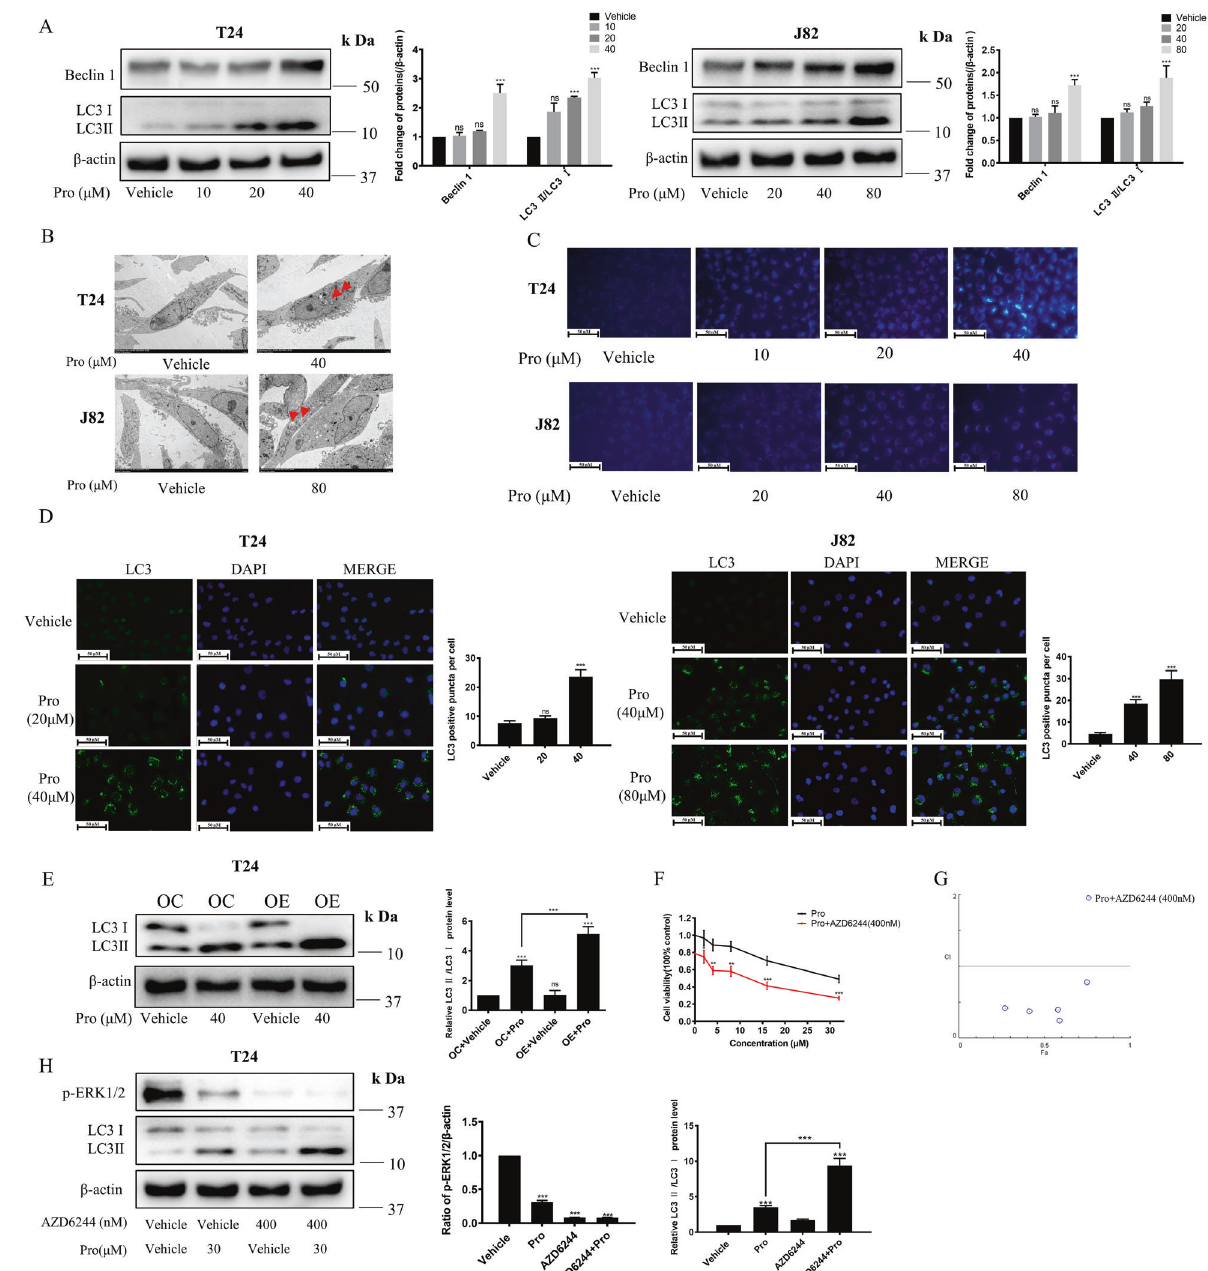
Fig. 6 Proguanil induces autophagy in BC cells. A T24, J82 were plated in 6-well plates (3.0 × 10 5 /well). When the cell density reaches 70 – 80%, cells were treated with proguanil for 12 h, and the protein expressions of LC3 and Beclin-1 were detected by WB. B When the density of T24 and J82 reaches 70 – 80% in 75 cm 2 vented culture fl asks, cells were treated with proguanil for 12 h. Subsequently, cells are then fi xed with electron microscope fi xative and observed under a transmission electron microscope (Red arrows indicate autophagosomes). C T24, J82 were plated on glass disks in 12-well plates (8.0 × 10 4 /well) and treated with proguanil for 12 h. Subsequently, cells washed with wash buffer and stained with MDC as described in “ Materials and methods ” , and then observed under an inverted fl uorescence microscope. D T24, J82 were plated on glass disks in 12-well plates (2.0 × 10 4 /well), After 24 h, cells were treated with proguanil for 12 h. The effect of proguanil on LC3 was detected by immuno fl uorescence. E T24, OE-T24 were plated in 6-well plates (3.0 × 10 5 /well). When the cell density reaches 70 – 80%, cells were treated with proguanil for 12 h, the effect of proguanil on the expression of LC3 was detected by WB. F T24 were plated in 96-well plates (6.0 × 10 3 /well) and pretreated with 400 nm AZD6244 for 12 h before exposure to increasing concentrations of proguanil for an additional 72 h, the combined effect of proguanil and AZD6244 was detected by MTT assay. G Combination index (CI) among the combinations of two drugs was calculated using CompuSyn software. if CI > 1, it denotes antagonism; if CI < 1, it denotes synergism. CI values in all of combinations were less than 1, indicating synergism. H T24 were plated in 6-well plates (3.0 × 10 5 /well). When the cell density reaches 70 – 80%, cells were pretreated with 400 nm AZD6244 for 12 h before exposure to proguanil for an additional 12 h, the protein expressions of p-ERK1/2 and LC3 were detected by WB. Data are representative of three independent experiments. Error bars represent means ± SD from triplicate experiments. Vehicle control means the concentration of DMSO lower than 0.3% (* P < 0.05, ** P < 0.01, *** P < 0.001, ns not signi fi cant).